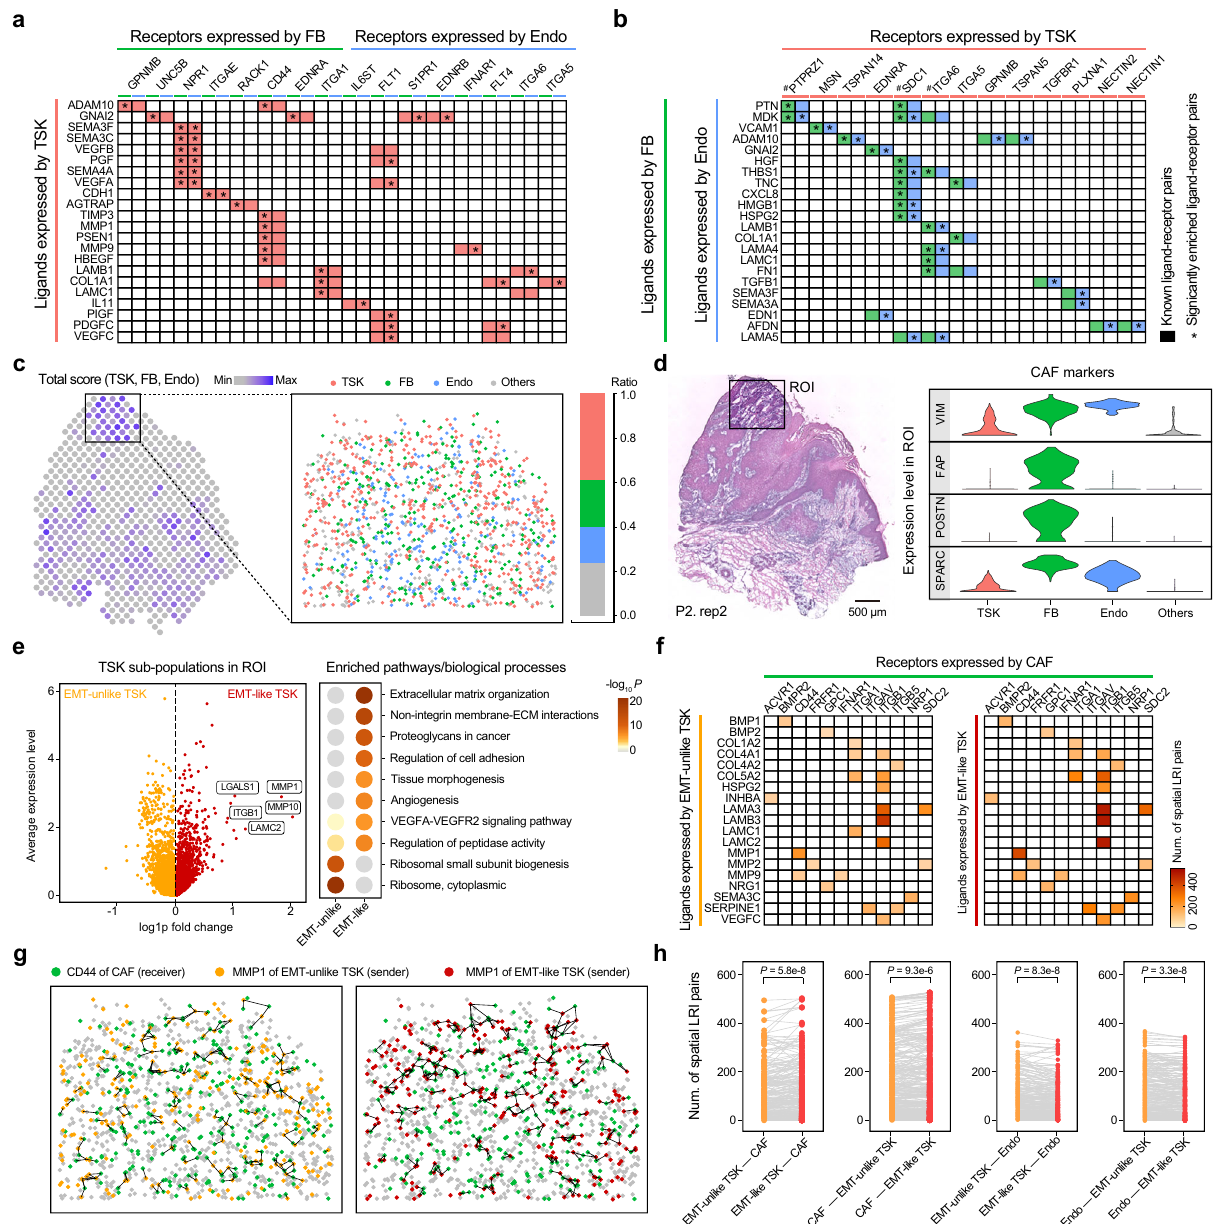
Fig. 6 | Reconstruction of cell – cell communications between TSK subpopula- tionsandstromalcellsinspacewithSpaTalk.a Top20inferredLRIsthatmediate cell – cell communication from the TSK senders to the FB and Endo receivers. Colored blocks represent the known ligand – receptor pairs in CellTalkDB. The asteriskrepresentsthesigni fi cantlyenrichedLRIsdeterminedbySpaTalk. b Top20 inferred LRIs that mediate cell – cell communication from the FB and Endo senders toTSKreceivers. c Regionofinterest(ROI)covering42spatialspotsinspacewitha hightotalscoreofTSK,FB,and Endoaccording totheirsignaturegenes.Thepoint plot shows the decomposed single-cell ST atlas determined by SpaTalk. The number sign represents the receptor contributing to the proliferation and